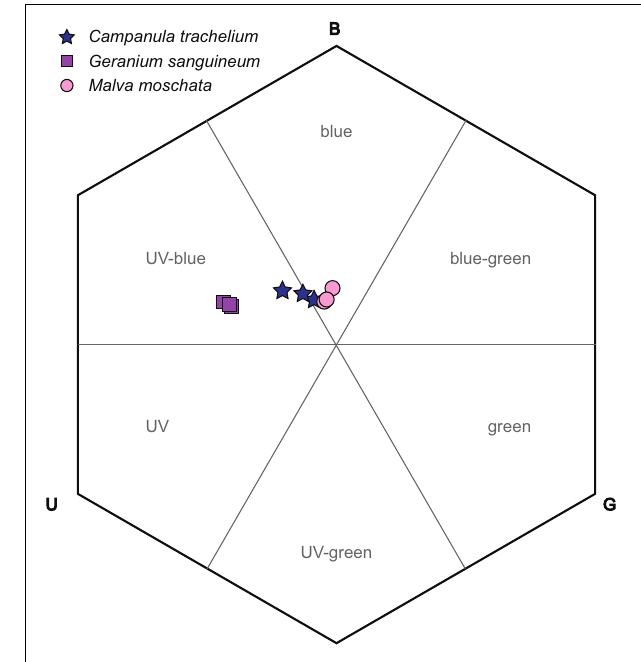
FIGURE 6 | Corolla color loci of C. trachelium , G. sanguineum , and M. moschata in the bee color hexagon based on the excitations of the UV, blue, and green receptors (U, B,